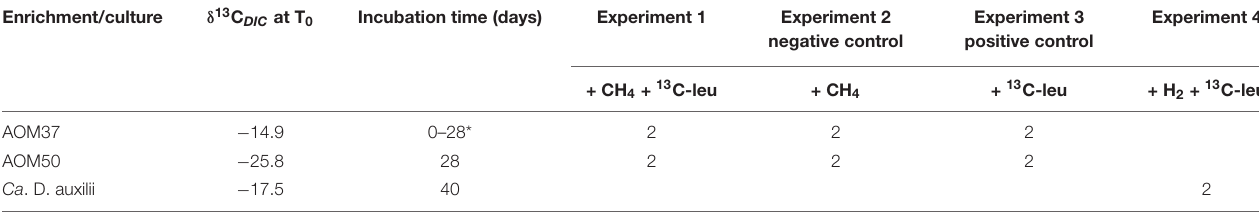
TABLE 1 | Overview of incubation